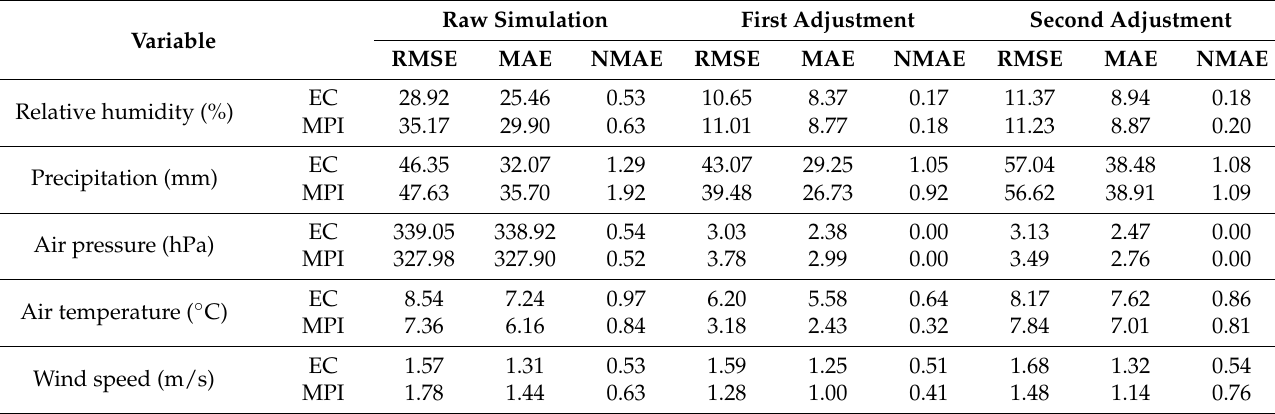
Table 1. Averaged performance of the Q-Q approach for monthly variables from EC-Earth 3 (EC) and MPI-ESM1.2-HR (MPI) GCM simulations over the 36 selected sites on the QTP against the site observations in terms of root mean square error (RMSE), mean absolute error (MAE) and normalized mean absolute error (NMAE). The results for the first and second adjustments refer to the calibrated results in the 1985–1999 and 2000–2014 periods, and the raw simulation refers to the uncalibrated GCM simulations in 1985–1999 as a reference before the adjustment. The second adjustment was made based on the results of the first adjustment. The units of RMSEs and MAEs are the same as those of the variables, while NMAE is dimensionless. N = 180 for each site. Raw Simulation First Adjustment Second Adjustment RMSE MAE RMSE